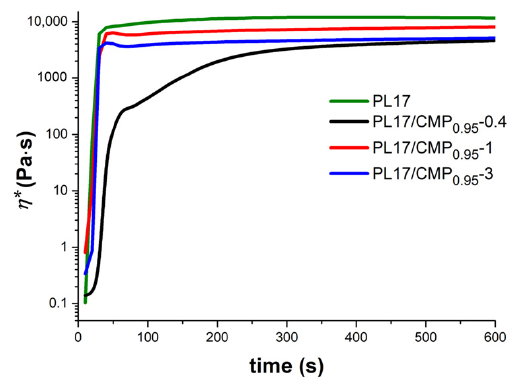
Figure 8. Complex viscosity of PL/CMP mixtures as a function of time when the temperature was switched from 5 °C to 37 °C ( ω = 1 rad/s, γ = 1%). switched from 5 ◦ C to 37 ◦ C ( ω = 1 rad/s, γ =